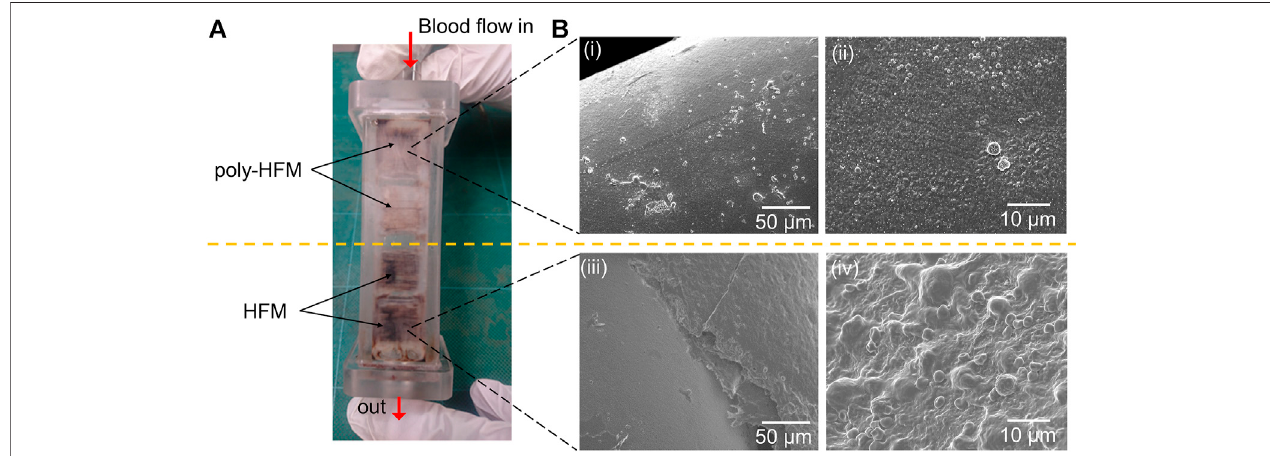
FIGURE8|(A) Photographofthechamber with16piecesofmembranes madeofthehollow fi ber(HFMs)after oneweekofimplantationingoat.Theupperpartof themembraneswascoatedwiththepolymer fi lm(poly-HFM),andthelowerpartwasleftuncoated. (B) TheSEMimagesofthehollow fi bercoatedwiththepolymer fi lm(i, ii) and those without polymer coating (iii,